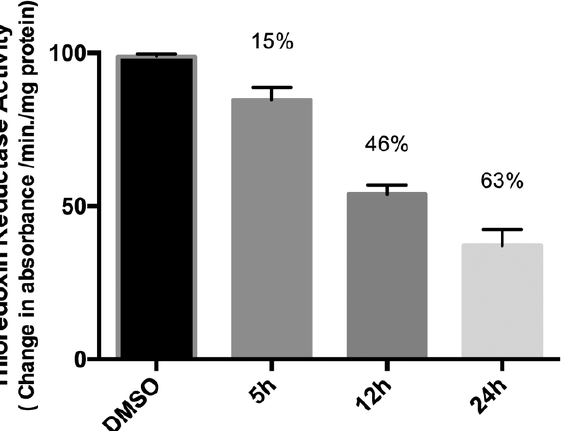
Figure 13. Activity of thioredoxin reductase of Caki-1 cells treated with 0.1% of DMSO (control) or complex 25a (5 µM) after 5, 12, and 24 h of incubation. (Reprinted with permission from ref. [51]. Copyright 2016 Royal Society of Chemistry).